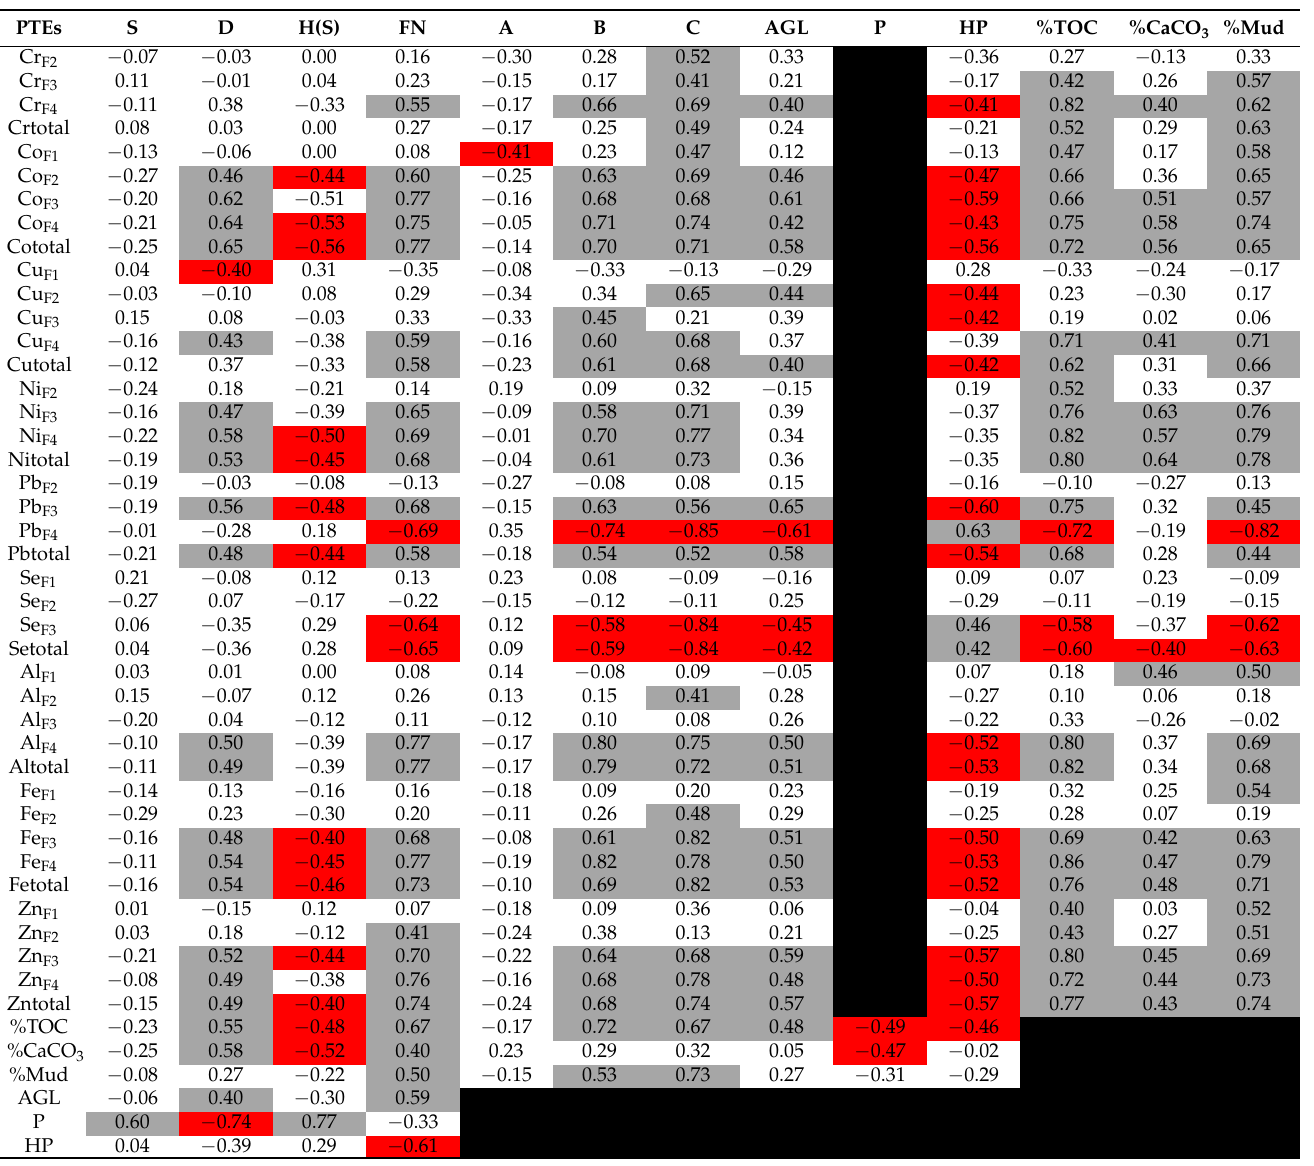
Table 3. Pearson correlation matrix of PTEs of interest (F1–F4 fractions), total organic matter (%TOC), mud (%mud), species richness (S), dominance (D), Shannon [H(S)], foraminiferal number (FN), A = Ammonia aoteana ; B = Ammotium salsum ; C = Trochammina , and percent abundances of agglu- tinated (AGL), porcelaneous (P), and hyaline-perforate (HP) benthic foraminifera ( n = 26; grey = significant positive correlation; red = significant negative correlation; black = correlation not consid- ered; p < 0.05